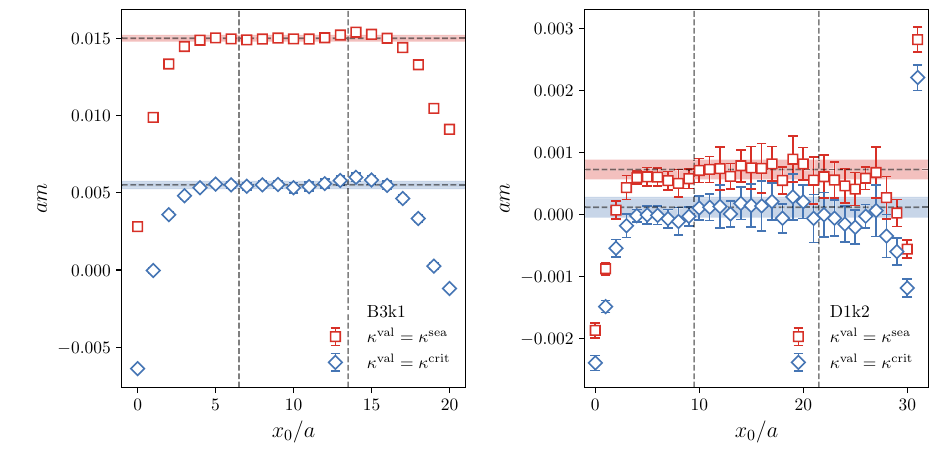
spond to the boundary fields ζ , while the filled circles denote ¯ ζ . The diagrams schematically represent traces, formed by starting from any point and following the lines (quark propagators) until we close the loop. The time ordering of points x and y is left unspecified in these diagrams